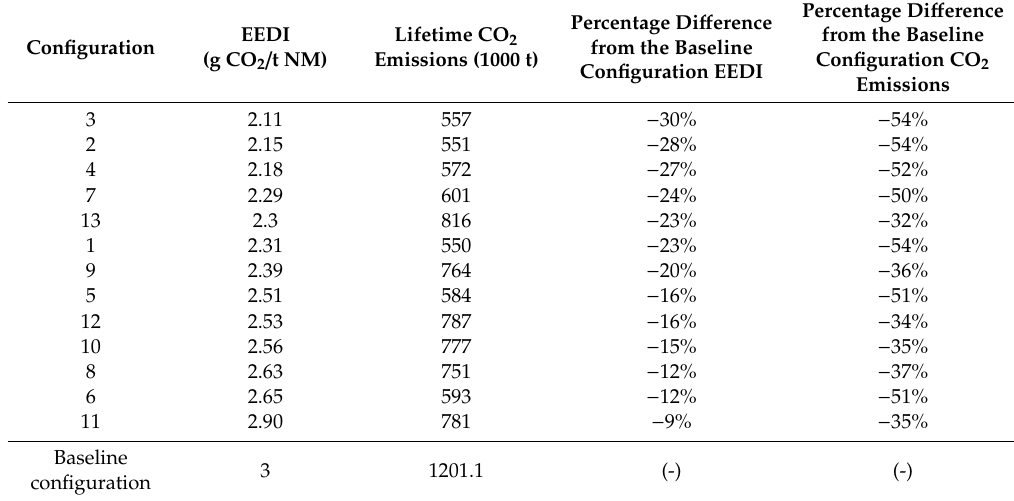
Table 12. Calculated EEDI values and lifetime CO 2 emissions for the Aframax tanker power plant solutions.